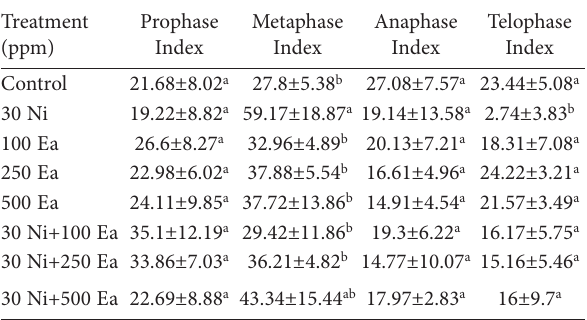
Table 2. Phase index of mitosis of A. cepa root tip cells after treat- ment with Ni, encapsulated E. acoroides leaves extract and mixture of Ni and encapsulated